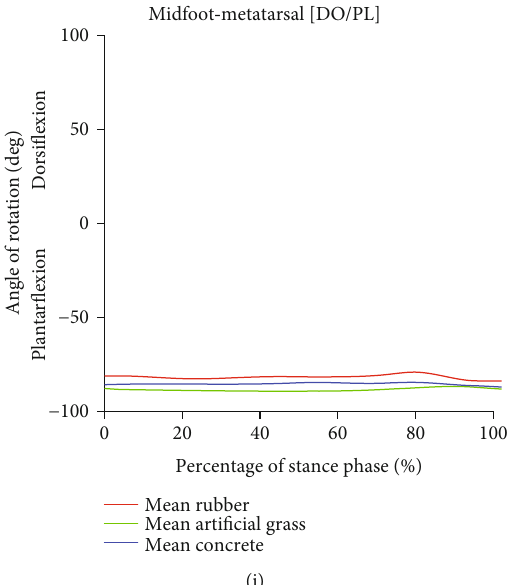
Figure 5: Angle of joint rotation in the foot segment of heeled shoe (HS) running: (a) calcaneus-metatarsal (eversion/inversion), (b) calcaneus-metatarsal (abduction/adduction), (c) calcaneus-metatarsal (plantar/dorsi fl exion), (d) calcaneus midfoot (eversion/inversion), (e) calcaneus-midfoot (abduction/adduction), (f) calcaneus-midfoot (plantar/dorsi fl exion), (g) midfoot-metatarsal (eversion/inversion), (h) midfoot-metatarsal (abduction/adduction), and (i) midfoot-metatarsal (plantar/dorsi fl